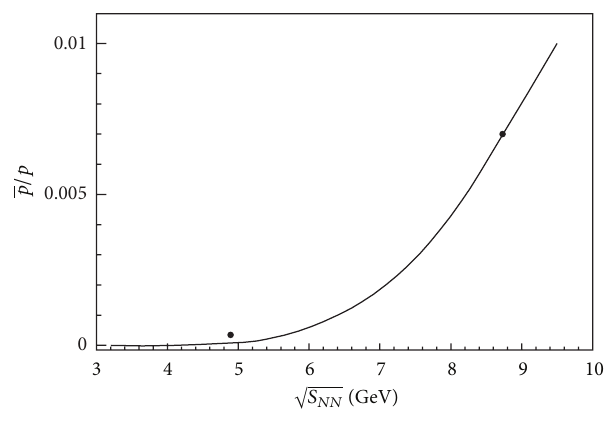
Figure 8: Variation of 𝐾 − /𝐾 + with respect to √𝑠 𝑁𝑁 . The results obtained from HSD and UrQMD are taken from [29]. Experimental data is taken from